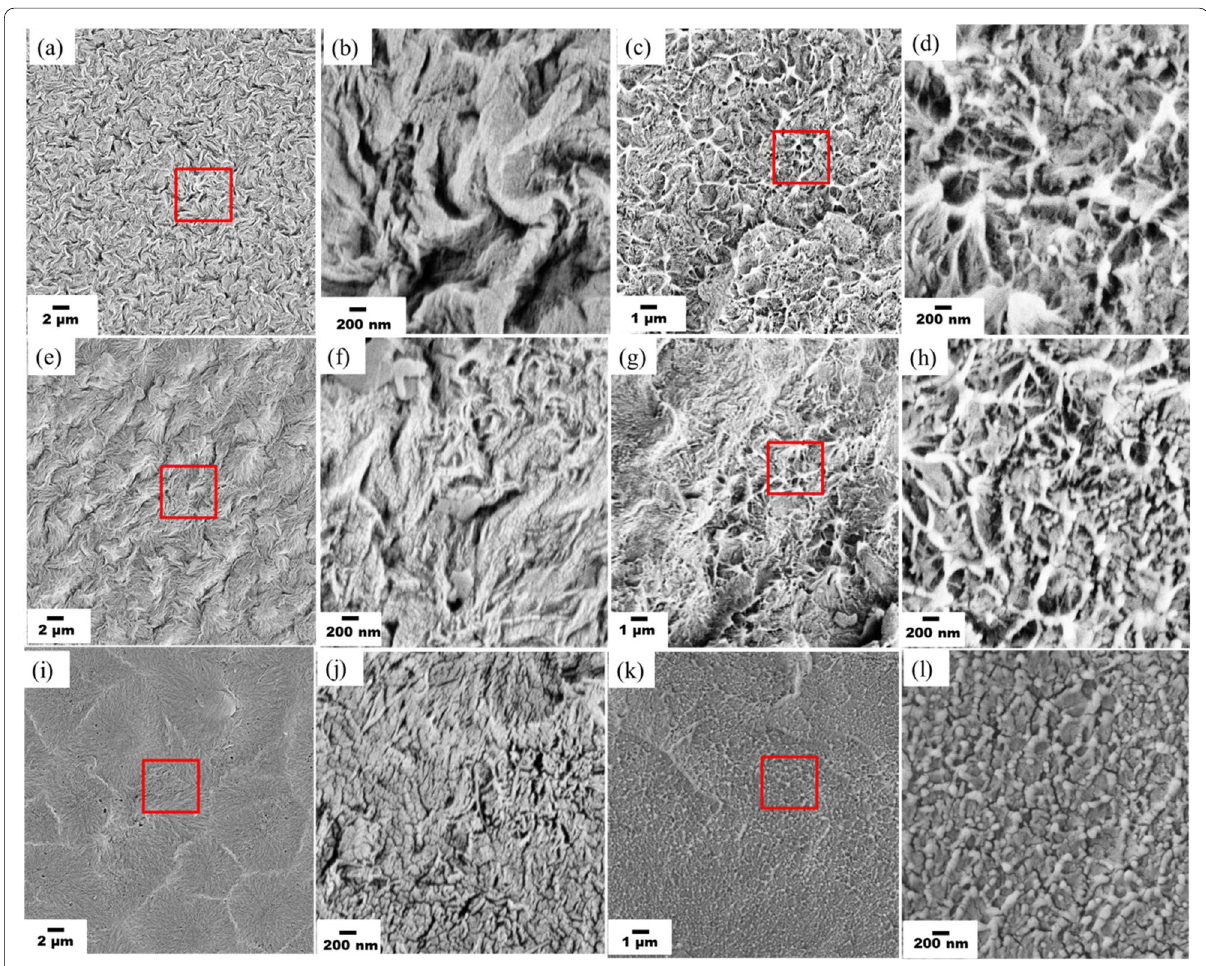
Fig. 4 Micrographs showing the surface ( a , b for 50/50 blend, e , f for 60/40 blend and i , j for 70/30 blend) and cross-sectional ( c , d for 50/50 blend, g , h for 60/40 blend and k , l for 70/30 blend) images of the membranes obtained from PVDF/PMMA